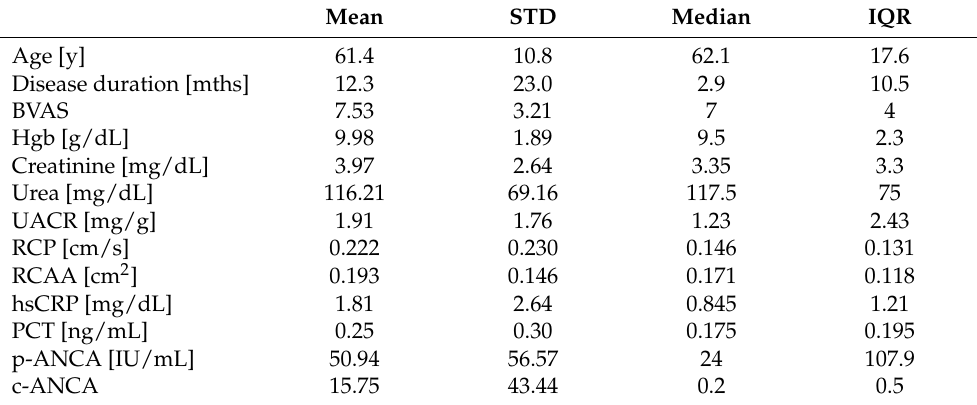
Table 2. Demographical and clinical data with blood and serum test results in the investigation group.